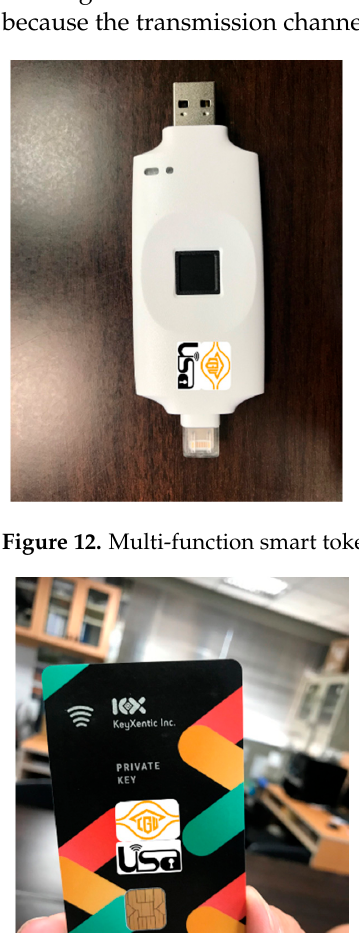
Figure 14. Interface of registration.